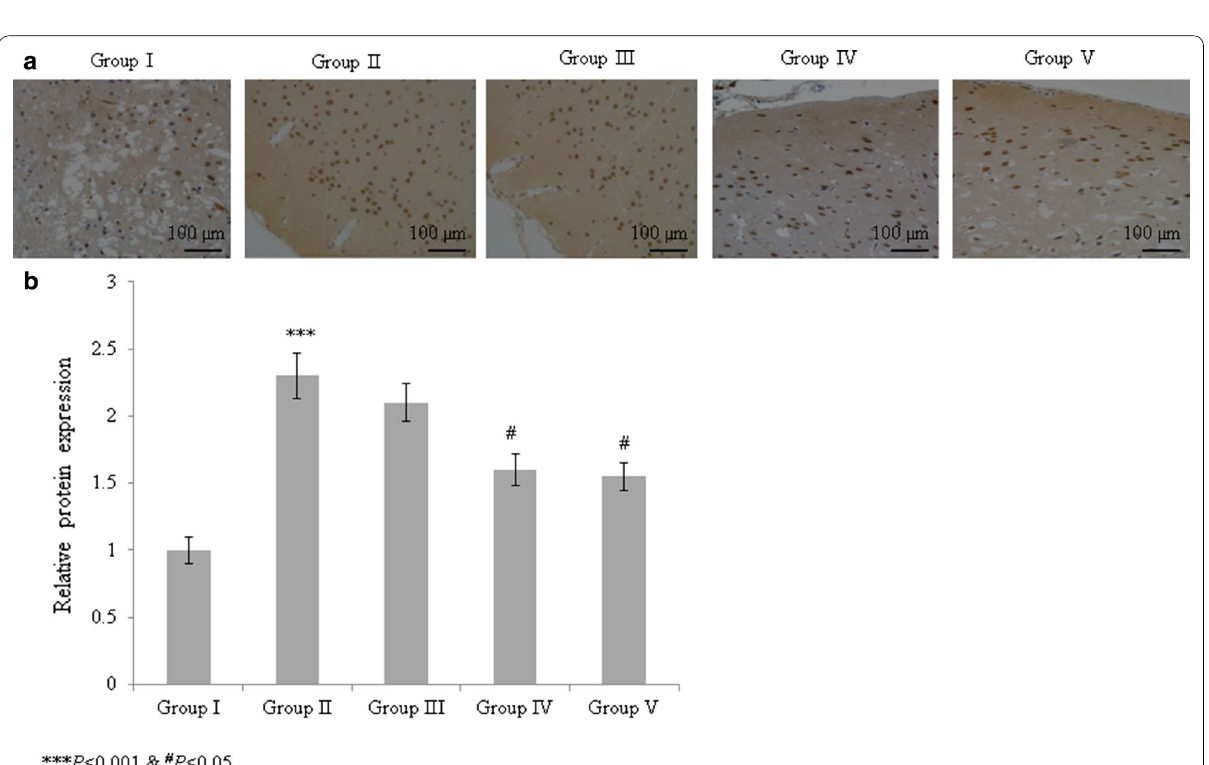
Fig. 5 The protective effect of a T. portulacastrum extract on protein expression of GPR124 in normal diabetic rats. a Immunohistochemical expression of GPR124 and b protein expression of GPR124. *** P < 0.001 vs. sham; # P < 0.05 vs. control. N